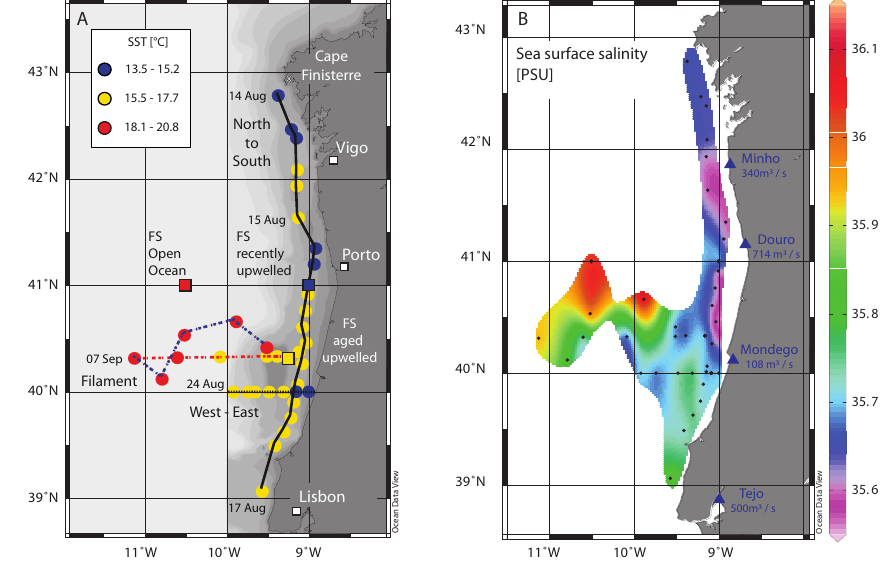
Fig. 1. (A) Cruise track of the Mouton campaign 2007 in the Iberian peninsula upwelling system. Samples were taken at different CTD stations (marked as dots) and along three different tracks (marked as lines). The solid line represents the north to south track within the upwelling. The dotted black line marks the west to east track which followed 40 ◦ N from the open ocean toward the upwelling. Dashed red and blue lines show a track following a filament. Fixed stations (FS, marked as squares) were sampled over 30h periods. Colours represent station clustering by sea surface temperature (SST). Date specifications are given for selected stations. (B) Sea surface salinity. River mouths of the most important rivers in the sampling area (blue triangles), with average